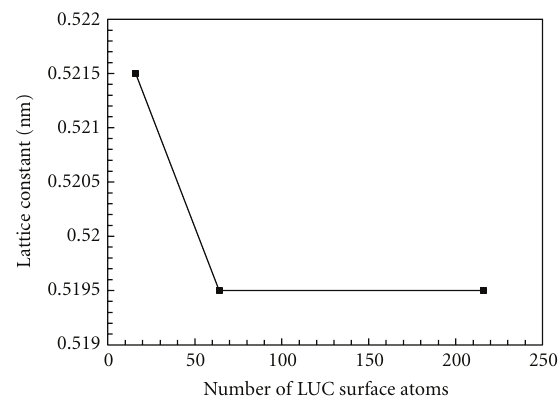
Figure 10: Lattice constant variation as a function of nanocrystal oxygenated (001)-(1 × 1) surface face.